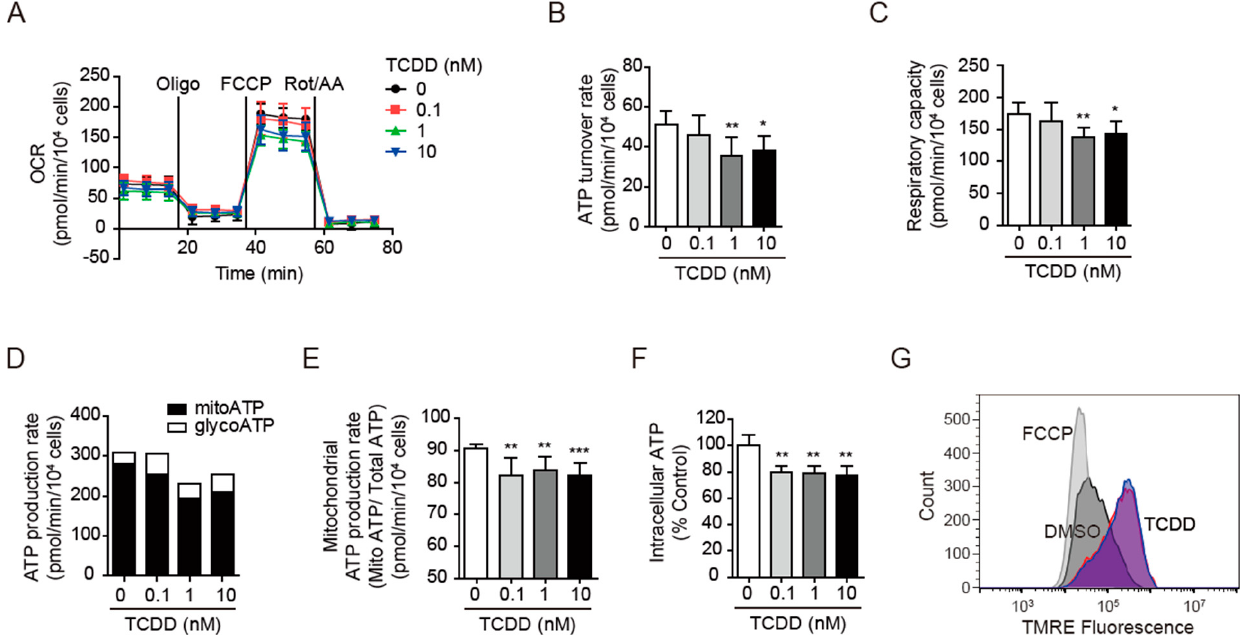
Figure 3. Impairment of mitochondrial activities by TCDD. ( A ) Oxygen consumption rate (OCR) profiles. C2C12 cells on an XF-24 microplate were pre-treated with TCDD (0, 0.1, 1, or 10 nM) for 48 h and OCRs were analyzed using a Seahorse XF-24 analyzer. Oligomycin (Oligo), FCCP, and rotenone/antimycin A (Rot/AA) were consecutively injected to obtain mitochondrial respiration capacities. ( B ) ATP turnover rate (basal OCR—oligomycin-inhibited OCR). ( C ) Respiratory capacity (FCCP-induced OCR). ( D ) ATP production rates from mitochondria (mitoATP, black bar) and glycolysis (glycoATP, white bar) were calculated from the OCR and ECAR. ( E ) Mitochondrial ATP production ratio. Ratio of mitoATP to total ATP. ( F ) Intracellular ATP contents in TCDD-treated cells were determined using CellTiter-Glo ® . Data are graphed as means ± SEM ( n = 4~6). Note: * p < 0.05, ** p < 0.01, *** p < 0.001 vs. DMSO-treated cells. ( G ) Flow cytometry histogram. The TMRE-mediated mitochondrial membrane potential was measured via flow cytometry. C2C12 cells were treated with 100 pM (red) or 10 nM (blue) TCDD for 48 h and stained with 1 μ M TMRE for 30 min, and the fluorescence levels of over 12,000 cells were analyzed. Cells treated with FCCP (10 μ M, white gray) for 1 h were used as the positive control.